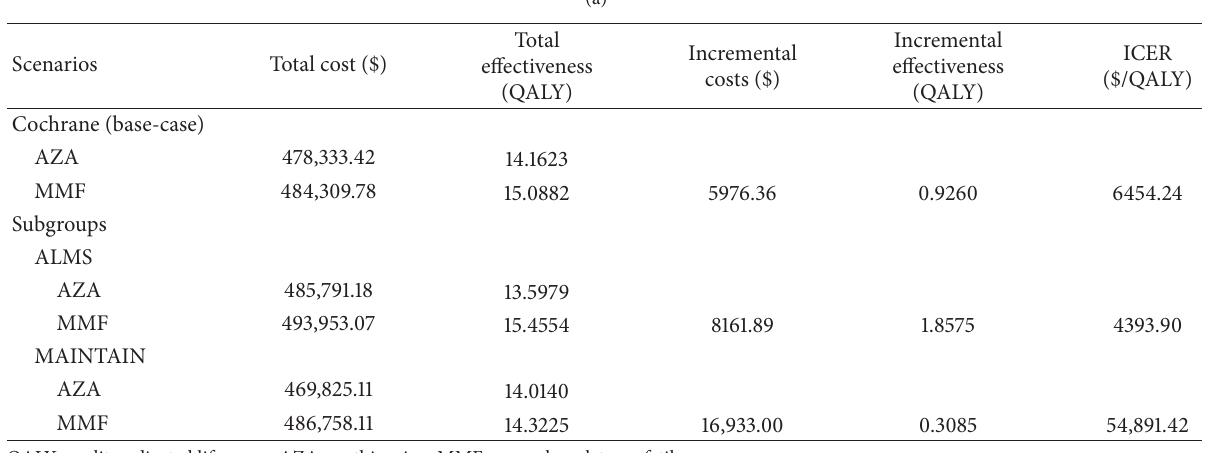
Table 4: (a) Costs, effectiveness, and incremental cost effectiveness ratios (ICER) of the base-case and individual clinical trials in lifetime model (40 years). (b) Sensitivity analysis of lifetime model using Cochrane